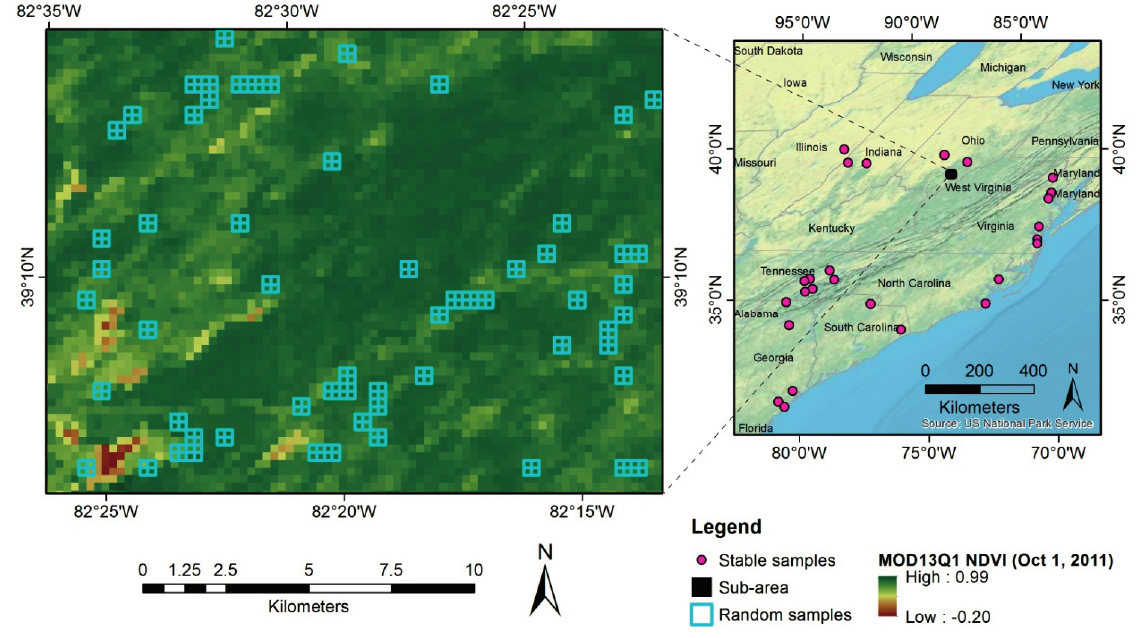
Figure 1. The locations of stable samples (no land-cover change), sub-area, and random samples in the sub-area. The image renders the MOD13Q1 NDVI acquired on 1 October 2011 shown in the extent of the